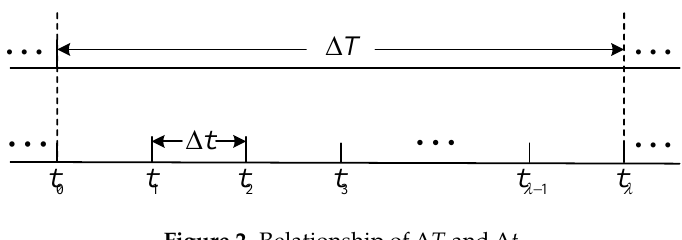
Figure 2. Relationship of ∆ T and ∆ t